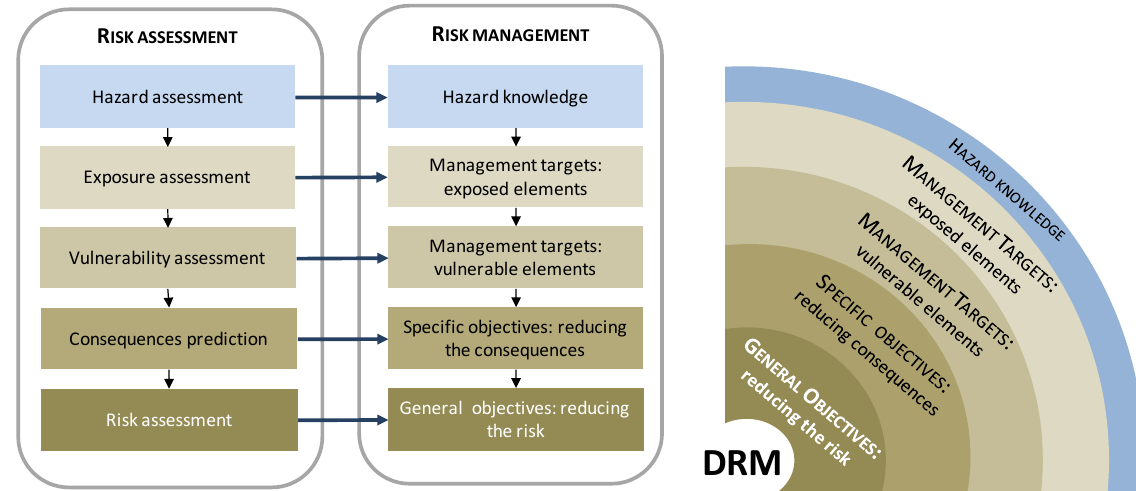
Figure 8. Left: translating vulnerability and risk results into a management framework. Right: disaster risk management (DRM) dartboard